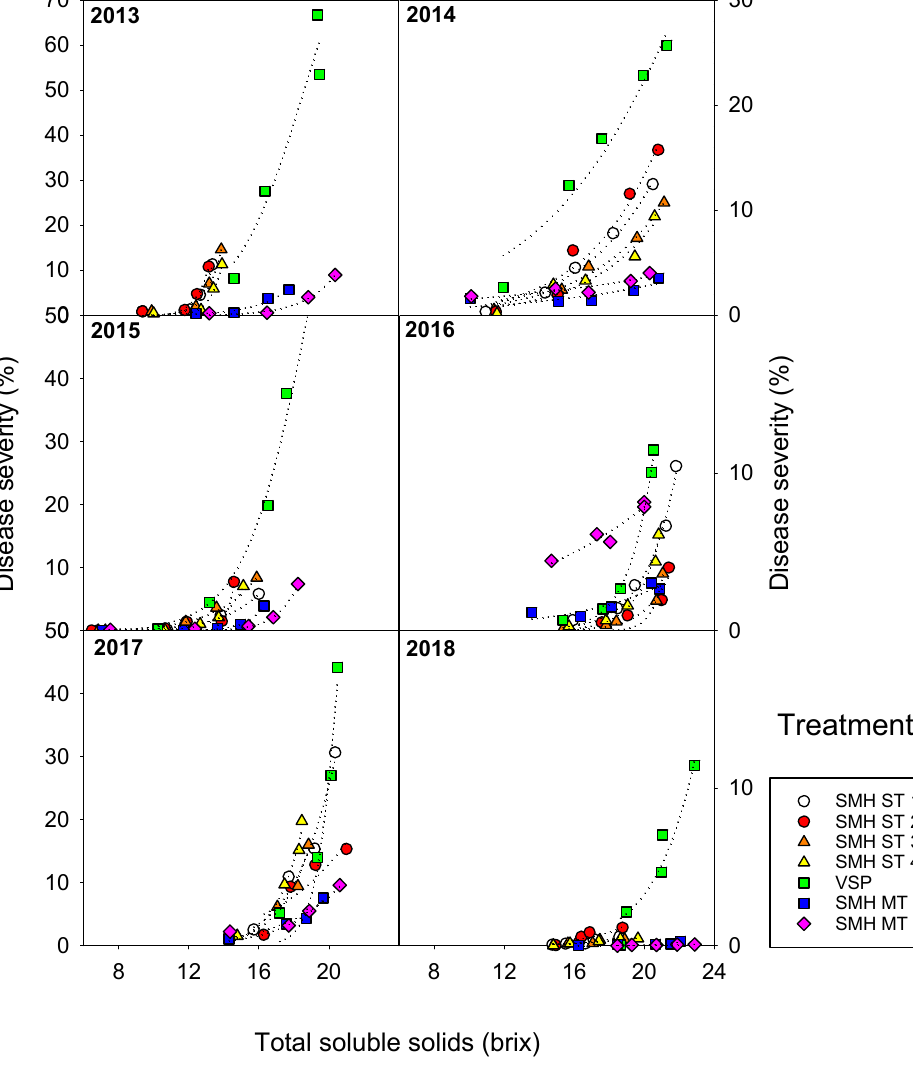
Figure 4. Progress of the disease severity of B. cinerea in the different treatments between 2013 and 2018 as functions of the total soluble solids. Plot symbols represent the observed disease severities, with the lines showing the calculated progress according to the sigmoidal equation type y = 100/(1 + e − ((x-x 0 )/b) ). SMPH, semi-minimal pruned hedge; ST, shoot topping; VSP, vertical shoot positioning; MT, mechanical thinning.